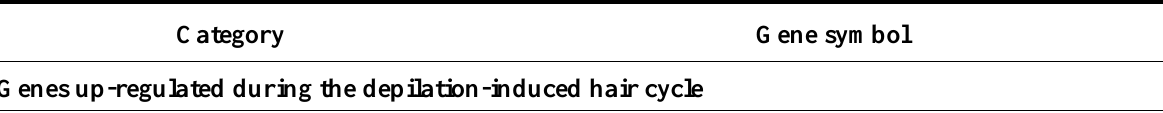
Table 1. Selected genes categorized according to their function that showed more than 3- fold changes in dorsal skin of male Mini rats after depilation of telogen-phase hairs at 10 weeks